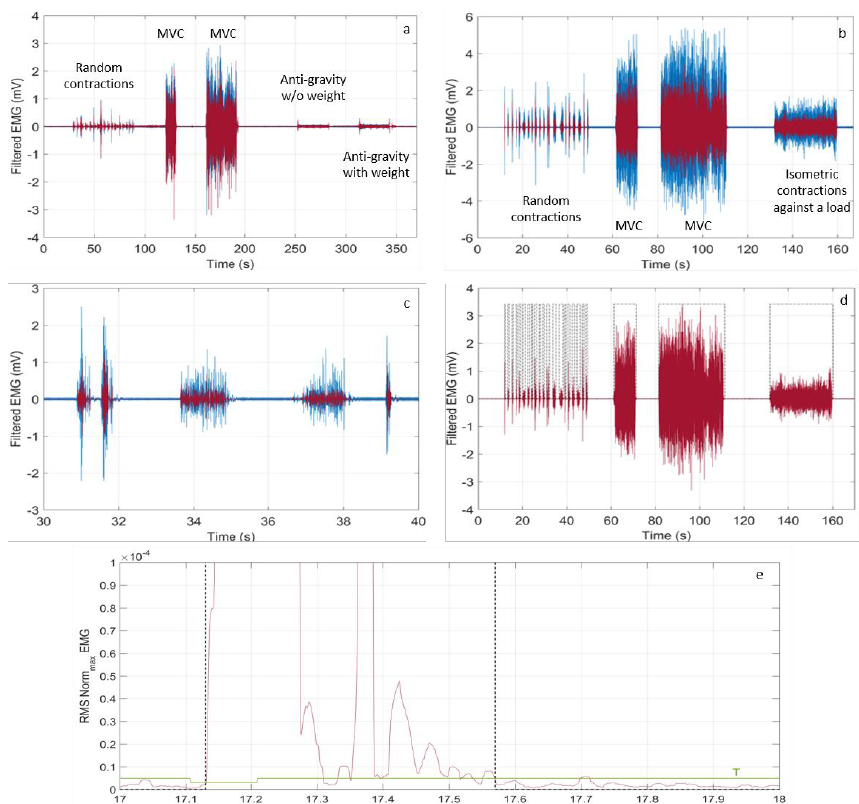
Figure 13. Filtered sEMG traces recorded with the wearable device (red line) and the Digitimer D360 (blue line) in the case of ( a ) biceps brachii contractions and ( b ) the abductor pollicis brevis; ( c ) zoom of the repeated fast and sudden random contraction of the biceps brachii in the time interval between 30 s and 40 s; ( d ) classification of ON state interval times (shadowed black line) of the abductor pollicis brevis activity; and, ( e ) zoom of the ON classification (black dashed line) of the abductor pollicis brevis and the threshold T (green line).